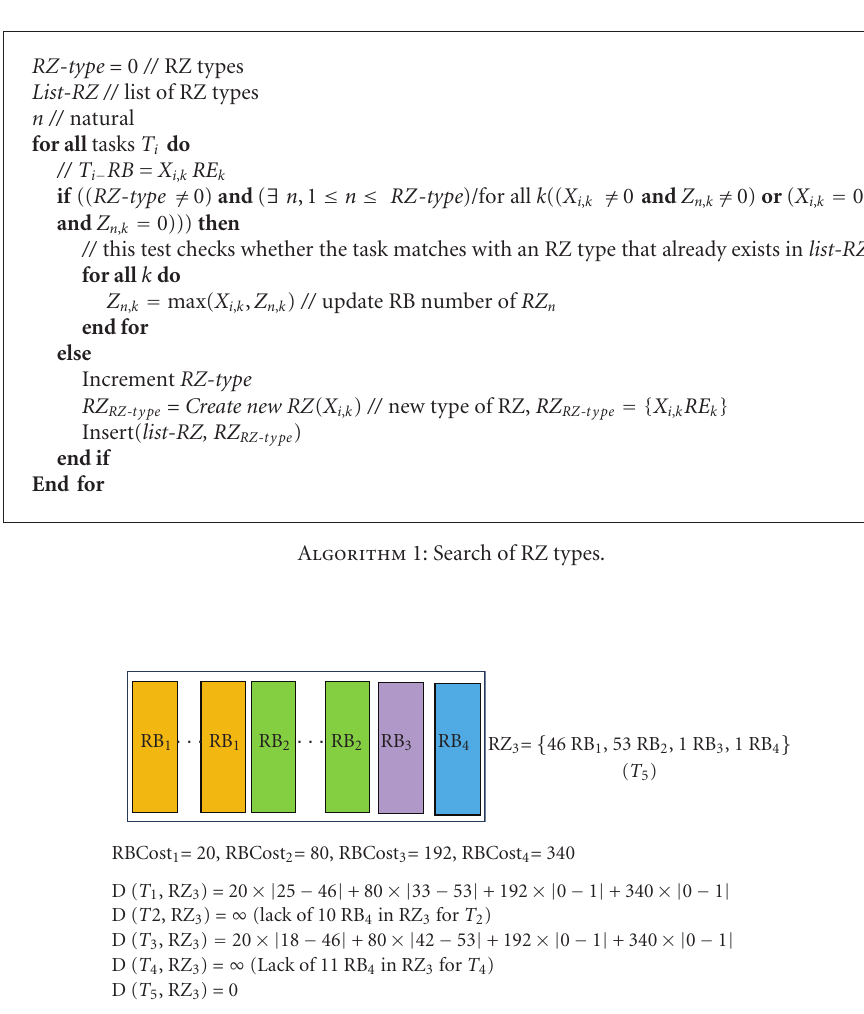
Figure 2: Example of computing cost D with RZ 3